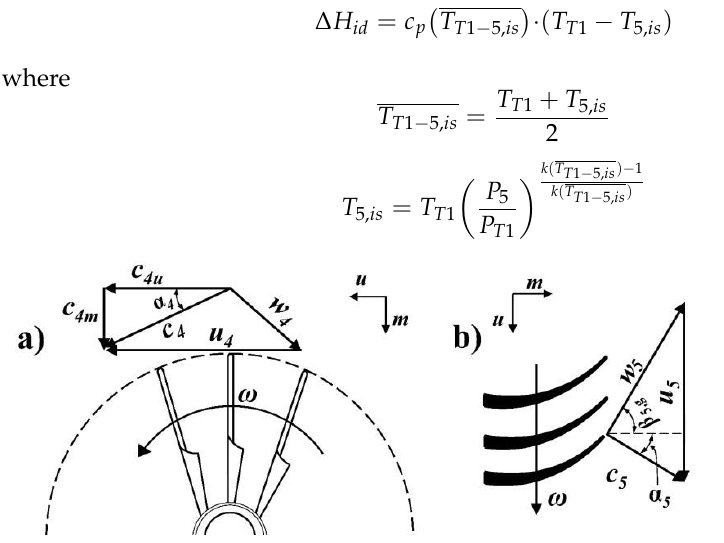
Figure 5. Velocity triangles ( a ) rotor inlet; ( b ) rotor outlet.